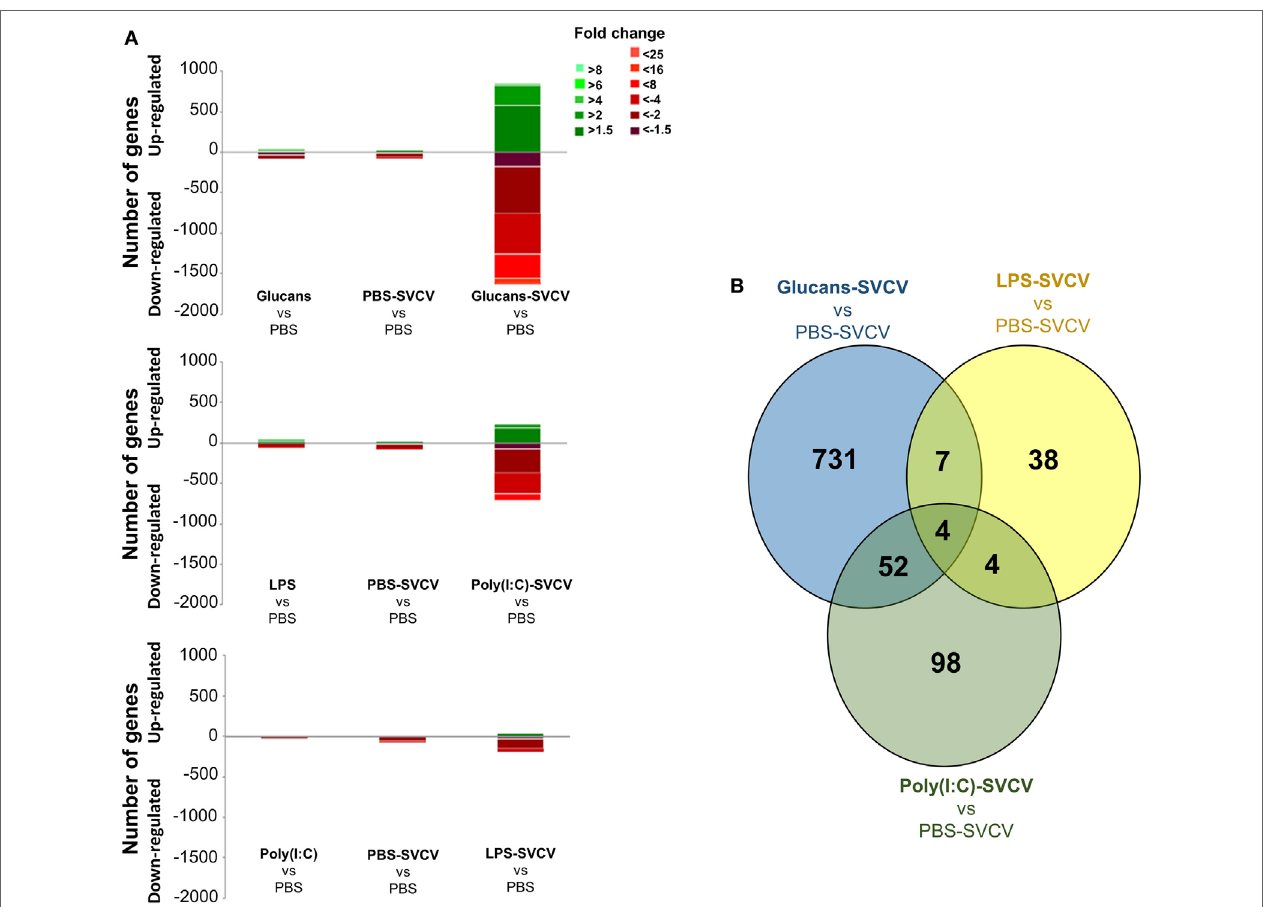
FigUre 2 | Analysis of gene modulation in the zebrafish kidney at 24 h postinfection with Spring Viremia Carp Virus (SVCV) in individuals that were previously stimulated with pathogen-associated molecular patterns (PAMPs). (a) Stacked column chart reflecting the distribution of the DEGs compared to individuals inoculated with phosphate-buffered saline (PBS). Statistically significant differentially expressed genes are subdivided according to intensity (fold change) and sense (up- and downregulation). (B) Venn diagram showing the number of shared and exclusive modulated genes after SVCV challenge in the three treated groups compared to PBS-SVCV fish. As observed in the absence of infection, the response was very exclusive depending on the